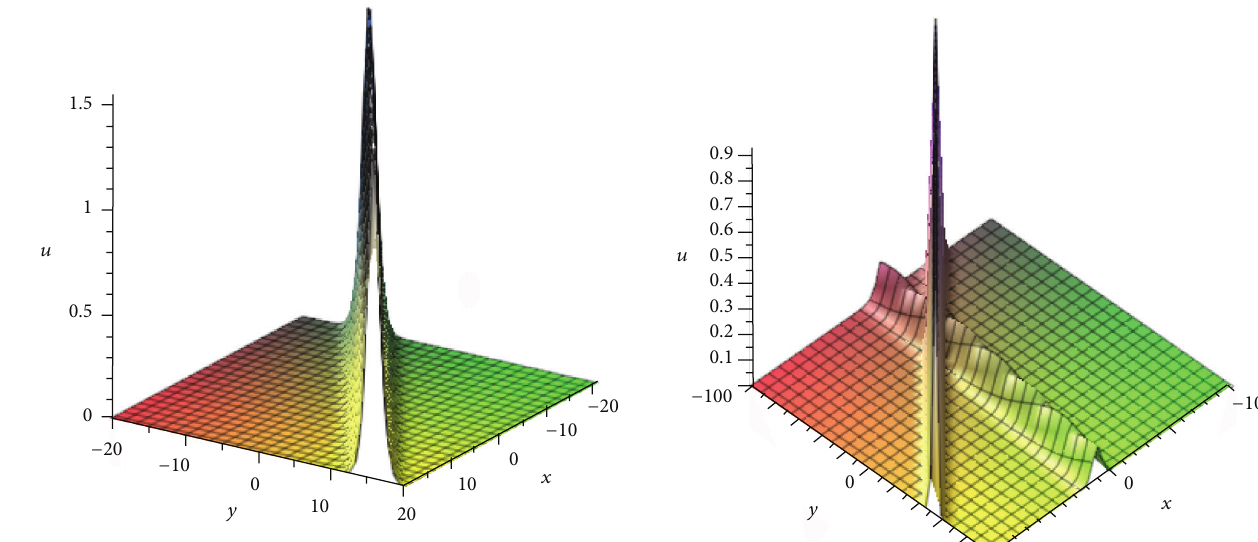
Figure 1: The shape and motion of the one-soliton solution for 𝜔 = −0.8 , 𝑎 = 1 , 𝑏 = 1 , 𝑐